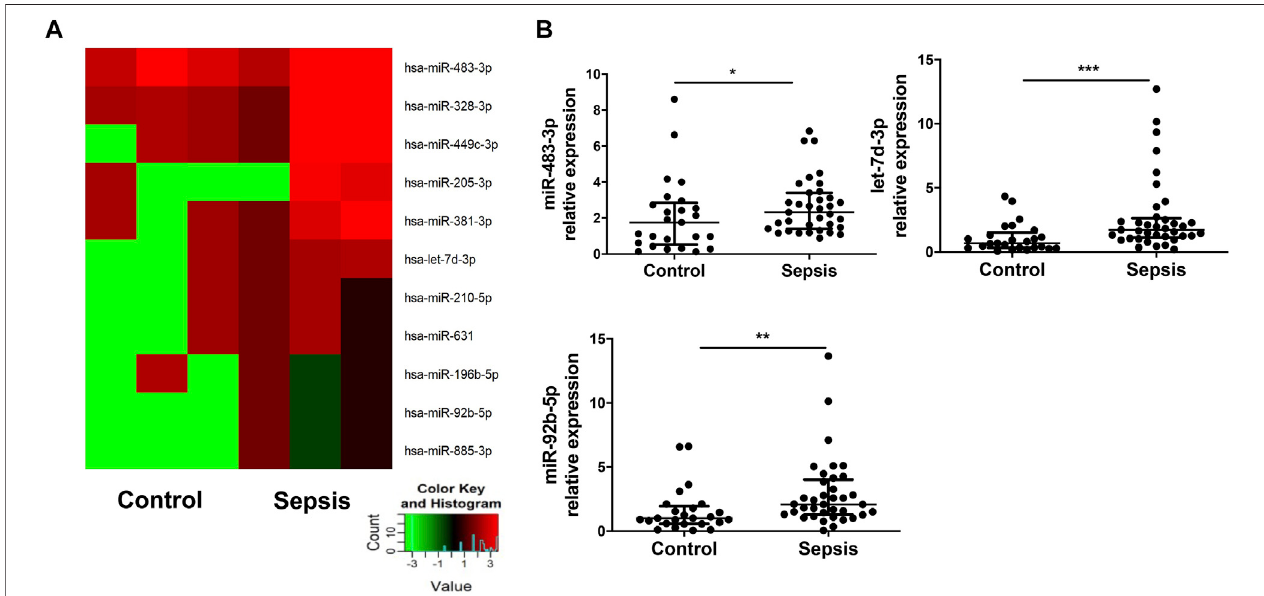
FIGURE 2 | Elevated levels of miR-483-3p, let-7d-3p, and miR-92b-5p in EVs from sepsis patients. (A) miRNA pro fi le of plasma EVs from sepsis patients and heathycontrolsfromthediscovery cohortwasexamined via microRNAarrayandcomparedbetweenthetwogroups( n =3).ElevenmiRNAsdemonstrated greaterthan 2-fold increase ( p value between 0.001 and 0.12) in sepsis patients were chosen for hierarchical cluster analysis to produce the heat map. Green and red colors on the heatmapdenoteadecreaseandincreaseinmiRNAexpression,respectively.Thecolorintensitiescorrespondtorelativeexpressionlevels. (B) The6of11 miRNAs relating in fl ammation and injury were analyzed using qRT-PCR in a larger set of EV samples from the validation cohort. Three of the 6 miRNAs had elevated levels in sepsis group. The plot showed a median, interquartile range, and the individual data points. n = 25 for control. n = 35 – 37 for sepsis. * p < 0.05, ** p < 0.01, *** p < 0.001.